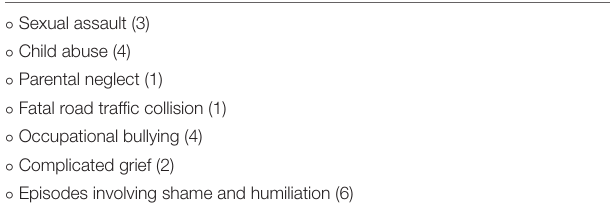
Results indicate savings in terms of time and efficiency, with additional health economic benefits. The results of hypothesis 4 results suggest the rejection of the directional